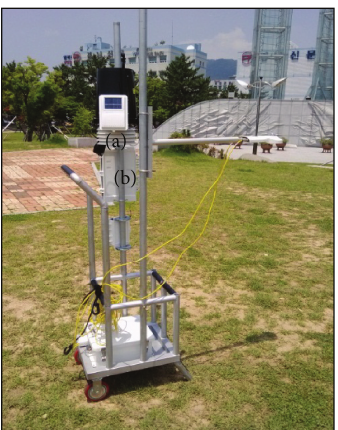
Figure 3: Portable measurement equipment: (a) meteorological measuring device, (b) data logger box.